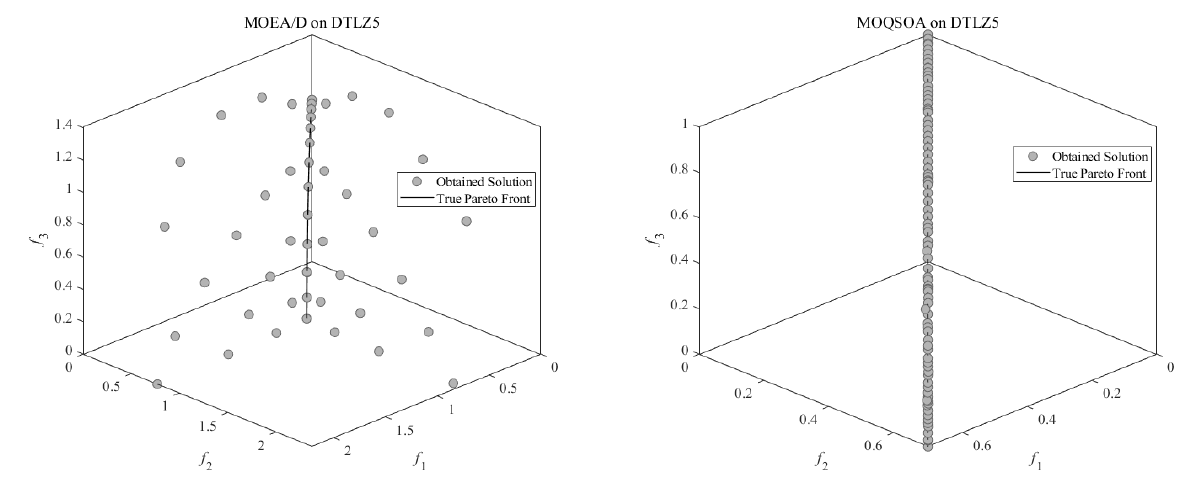
Figure 5. Pareto fronts of each algorithm for DTLZ5.